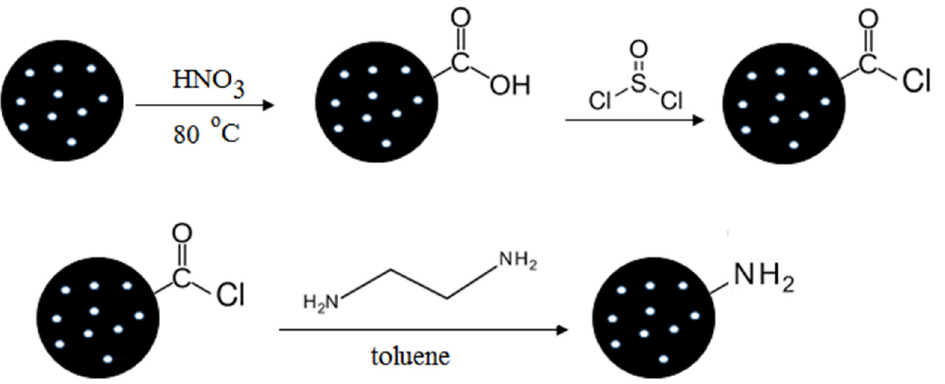
Figure 6. Surface functionalization of mesoporous carbons with concentrated nitric acid and ethylenediamine.